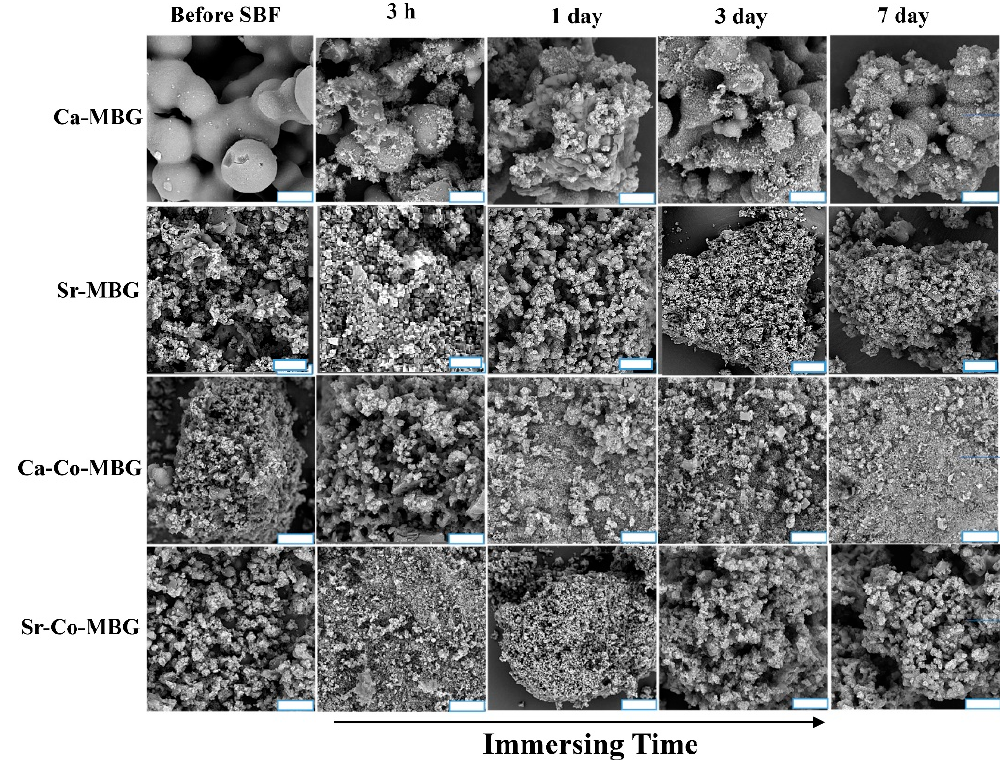
Figure7. FESEManalysisofimmersedMBGsinSBFinperiodsof3h, 1, 3, and7days. (Scale bar = 2 µ m). Figure 7. FESEM analysis of immersed MBGs in SBF in periods of 3 h, 1, 3, and 7 days. (Scale bar = 2 µm).